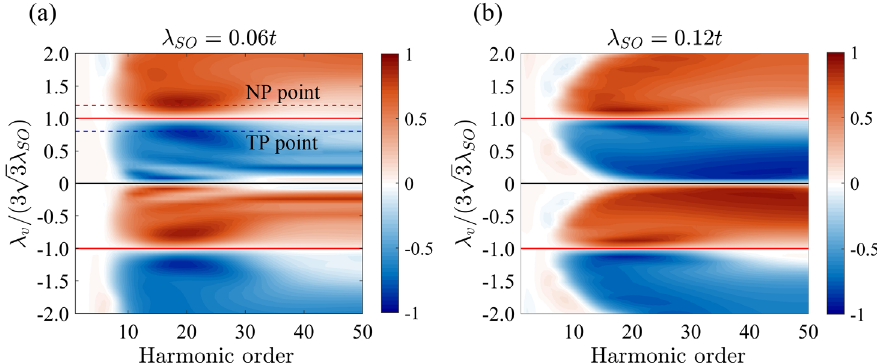
¼ 0 . 06 t and = λ and harmonic orders for (a) λ v SO SO